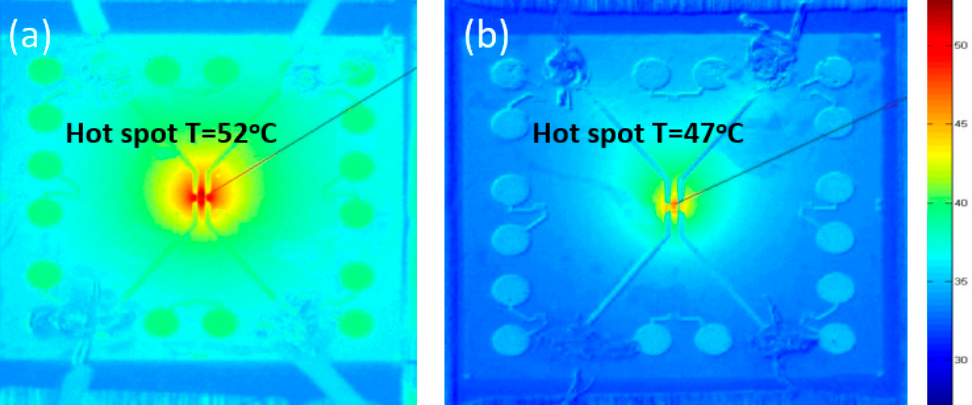
Figure 12. Temperature distributions on thermal test chips at a heat flux of 1280 W / cm 2 without ( a ) and with ( b ) a graphene heat spreader. Sourced from Reference [38].